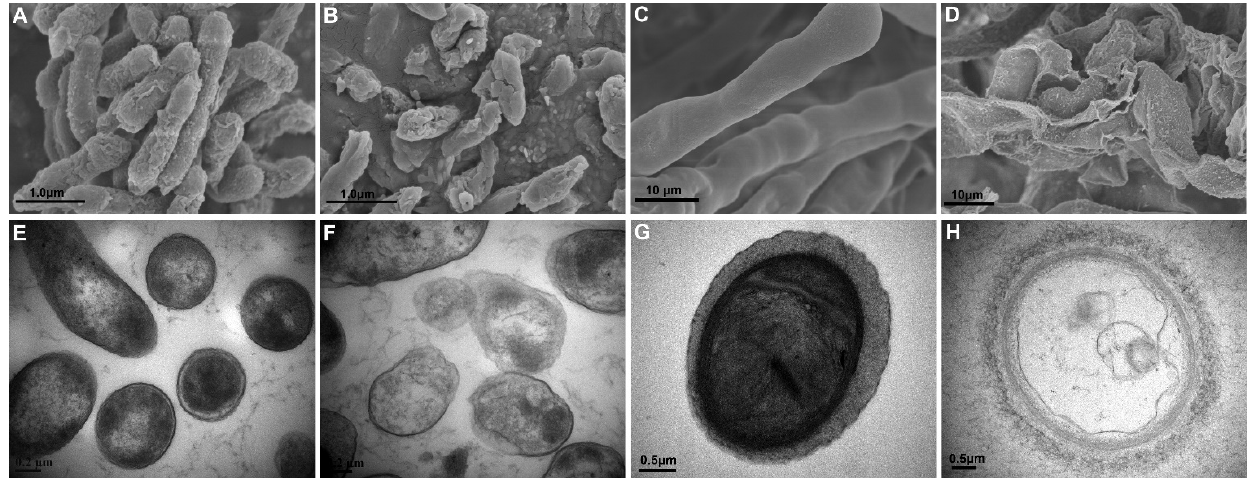
Figure 3. Structures of Pseudomonas syringae pv. actinidiae (Psa) cells and Botrytis cinerea hyphae shown by scanning electron microscopy ( A – D ) and transmission electron microscopy ( E – H ). Con- trol Psa cells are intact ( A , E ) with electron-dense cell contents ( E ), whereas Psa cells grown with 20% culture filtrate of strain XL17 are broken and shrunken ( B ) and lost cell contents ( F ). Control hyphae with smooth and intact cells walls ( C , G ) contain electron-dense cell organelles and contents ( G ), whereas hyphae grown with 20% culture filtrate of strain XL17 are broken and fragmented ( D ) and lost cell contents ( H ).